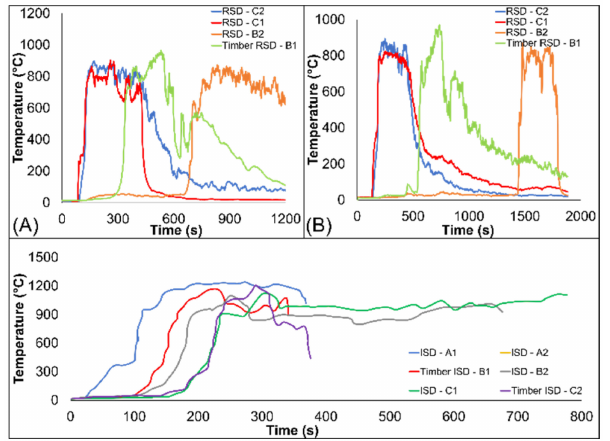
Figure 16. Six RSD experiments: ceiling temperature: top—temperature profiles of each RSD in ( A ) test 16, and ( B ) test 17, bottom—6 Nos ISDs from section of 20